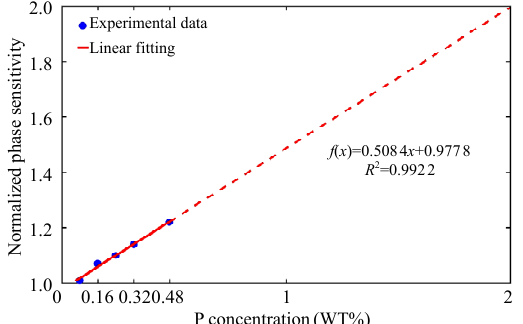
Fig. 42 Normalized phase sensitivity vs phosphorus-doping concentration of CSF.